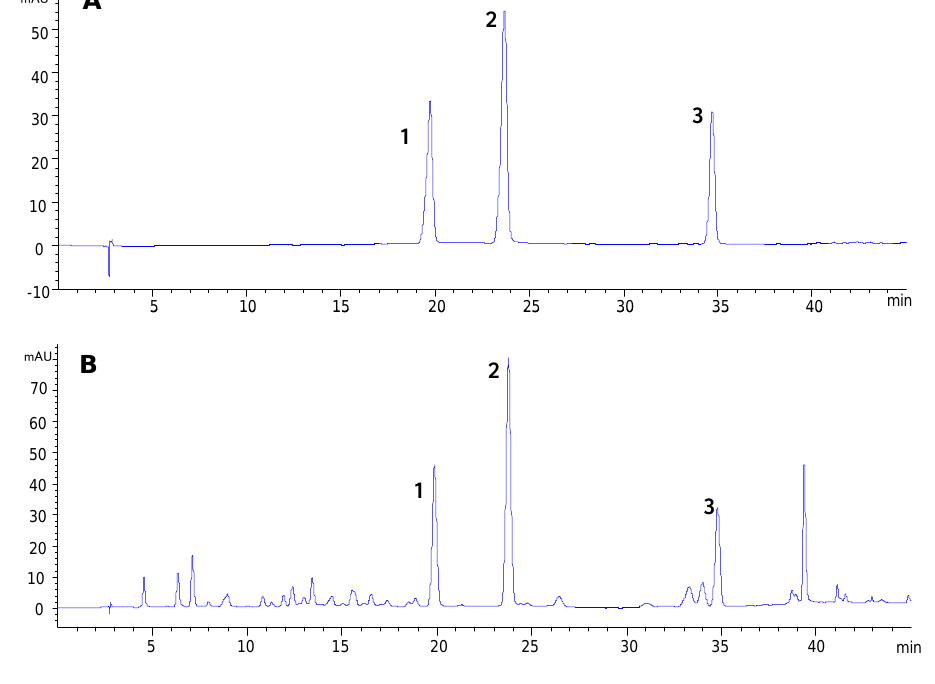
Figure 4. Typical HPLC-DAD chromatograms of the three flavonoid glycosides ( A ) and Microctis Folium ( B ). vitexin ( 1 ); isovitexin ( 2 ); isorhamnetin 3- O - β - D -rutinoside ( 3